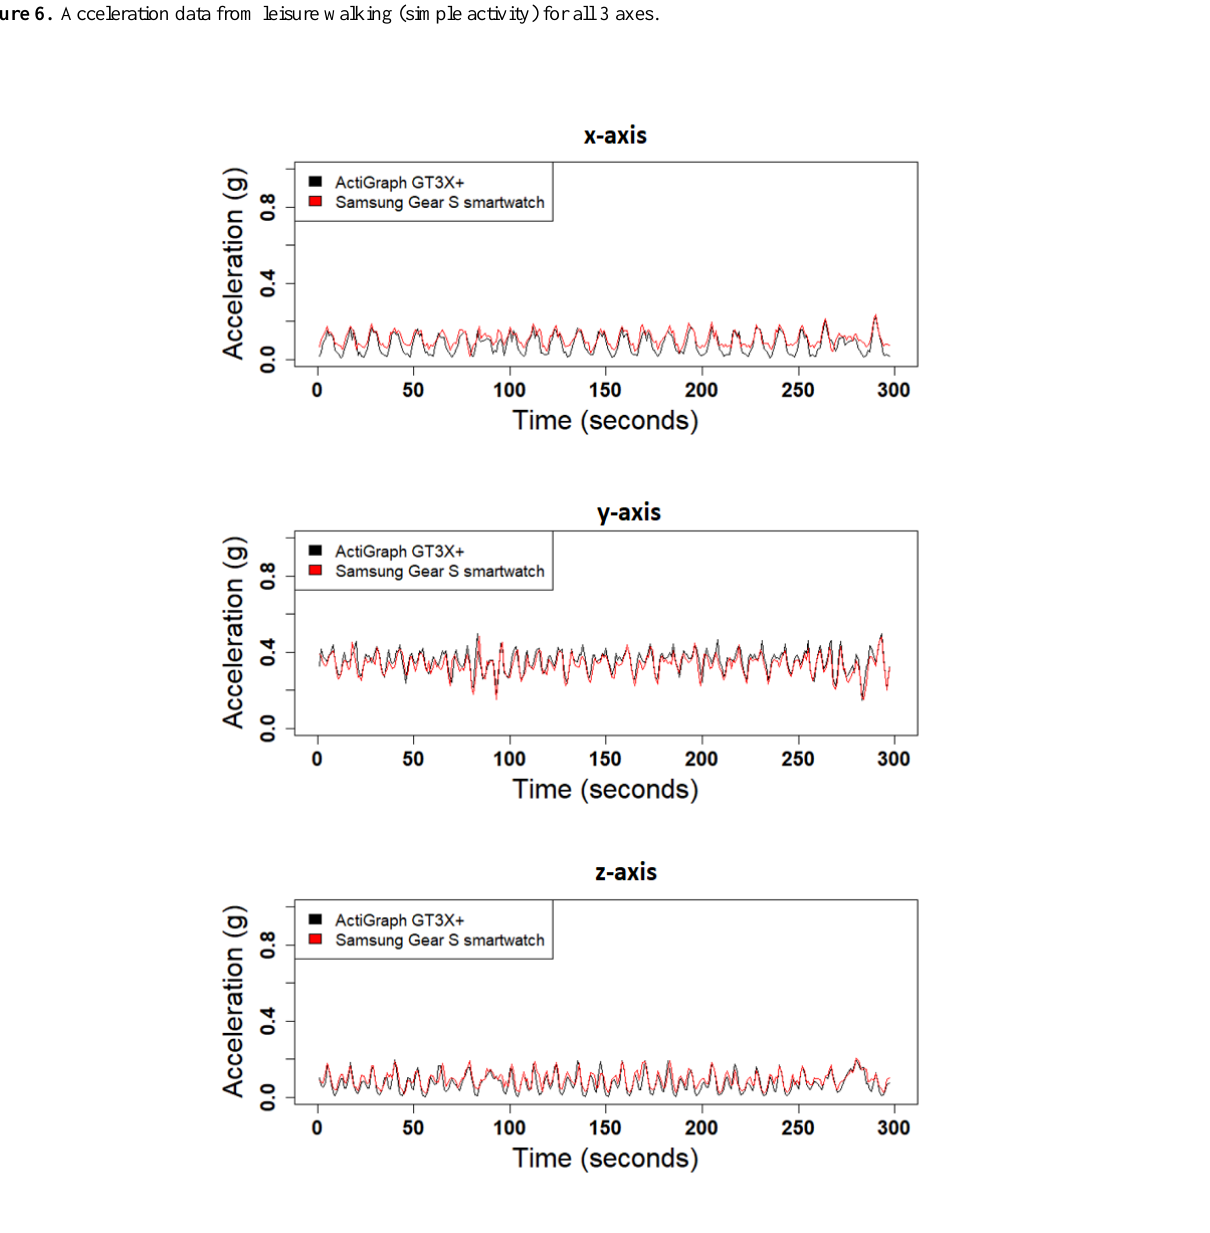
Figure 6. Acceleration data from leisure walking (simple activity) for all 3